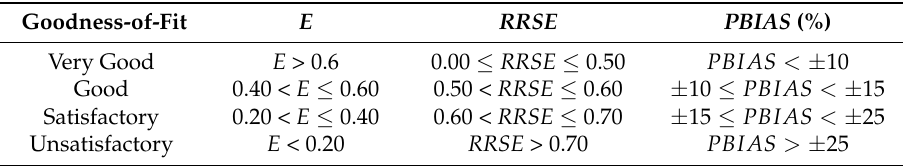
Table 1. Classification of the goodness-of-fit (adapted from